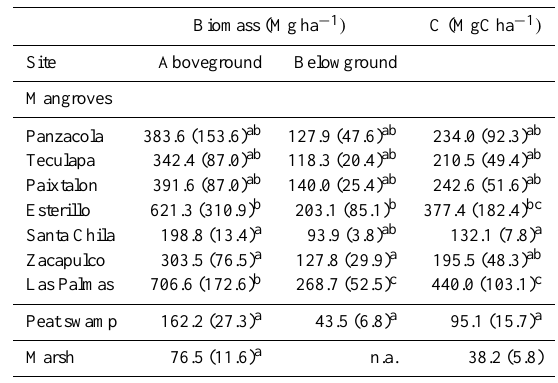
Table 3. Aboveground biomass, belowground biomass (Mgha − 1 ) and total carbon (C) in vegetation (MgCha − 1 ) within wetlands of La Encrucijada Biosphere Reserve. Values are shown as mean (stan- dard error). Different letters indicate significant differences among sites ( p <0.05). The marsh was not included in analysis due to miss- ing belowground biomass.